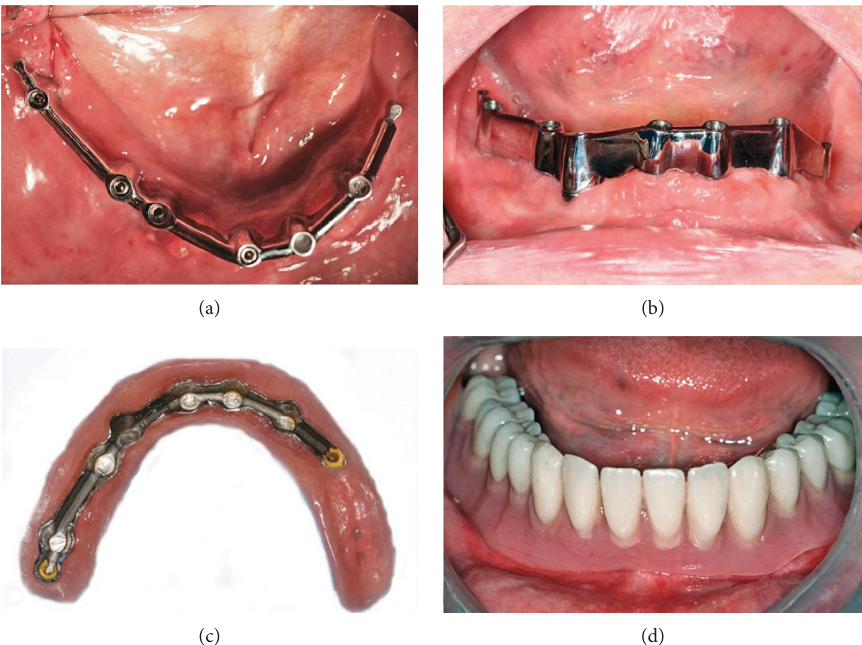
Figure 9: Clinical view of the final mandibular bar restoration after bar mounting. (a) Occlusal view after one week. (b) 30 days after loading. (c) Denture’s base. (d) Mandibular denture in situ.